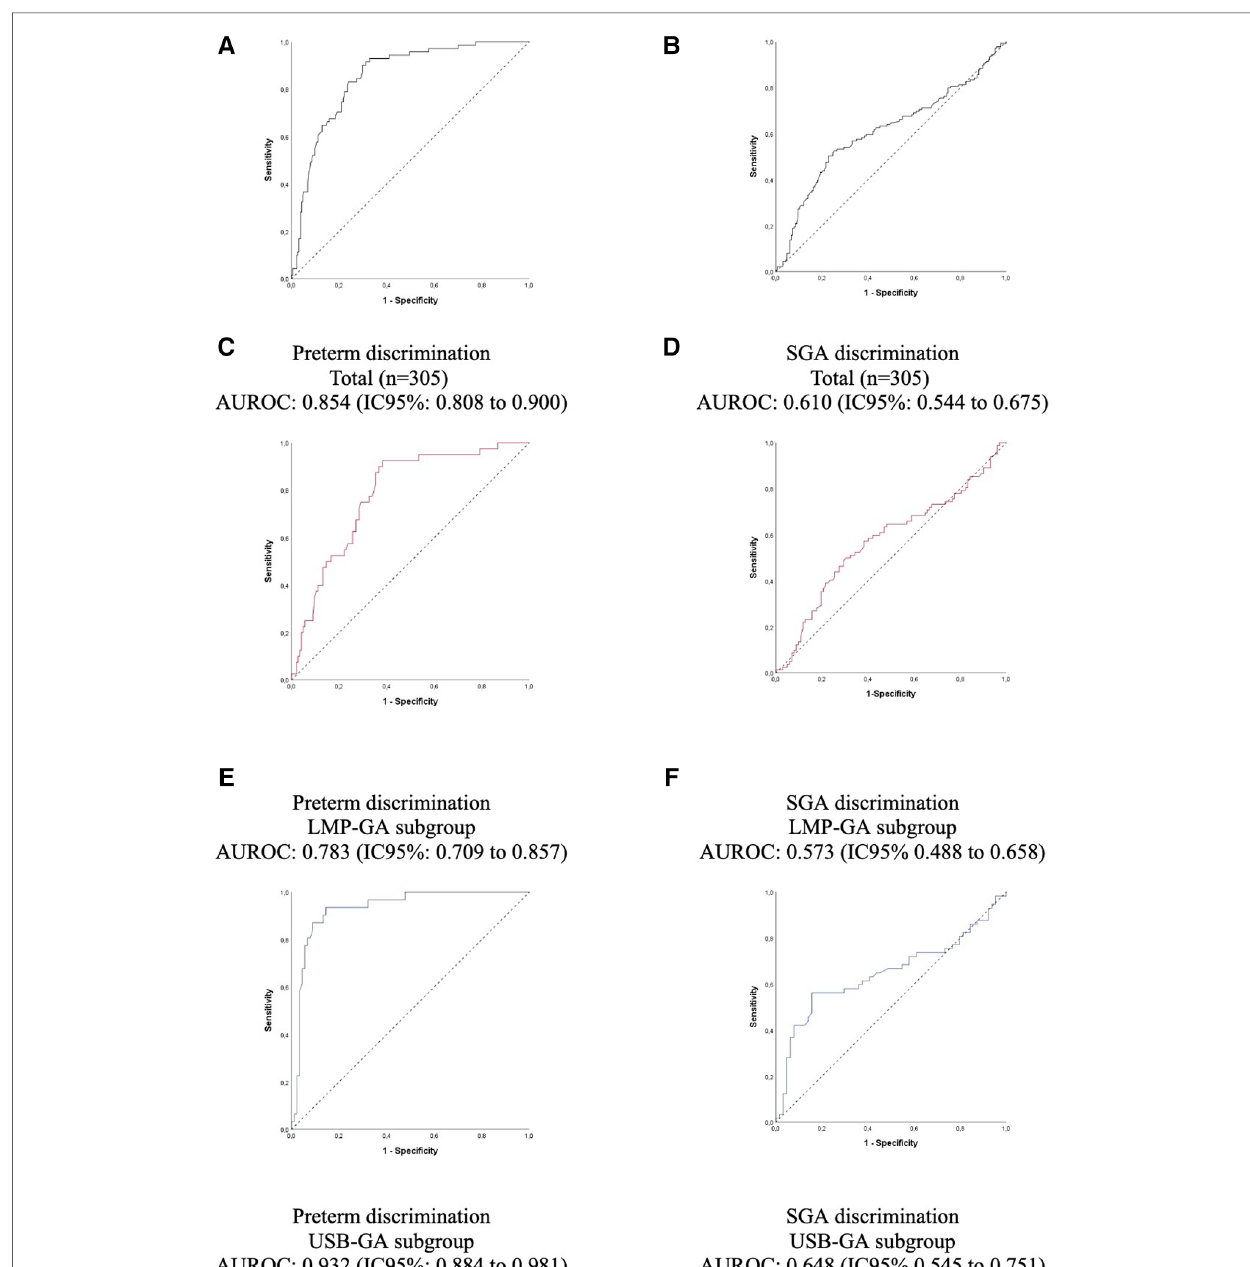
FIGURE 5 Accuracy of prematurity and small for gestational age with the gestational age predicted by the test ( A,B ), and predicted by the last menstrual period ( C,D ), predicted by the gestational age calculated using prenatal ultrasound before 24 weeks of gestation ( E,F ). AUROC, area under the receiver operating characteristic curve; GA, gestational age; LMP, last menstrual period; SGA, small for gestational age; LMP-GA, gestational age calculated using the last menstrual period; USB-GA, gestational age calculated using prenatal ultrasound before 24 weeks of